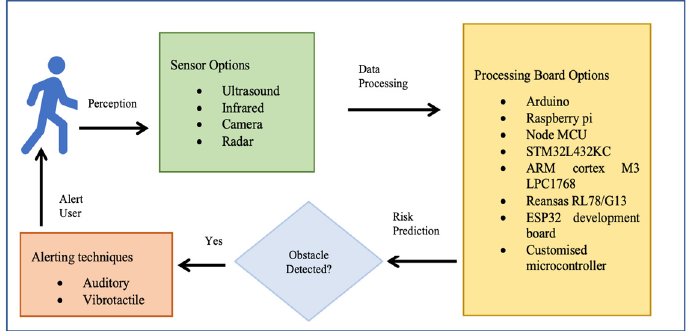
Figure 1. Schematic block diagram illustrating the main components of obstacle detection shoes, as used in the reviewed